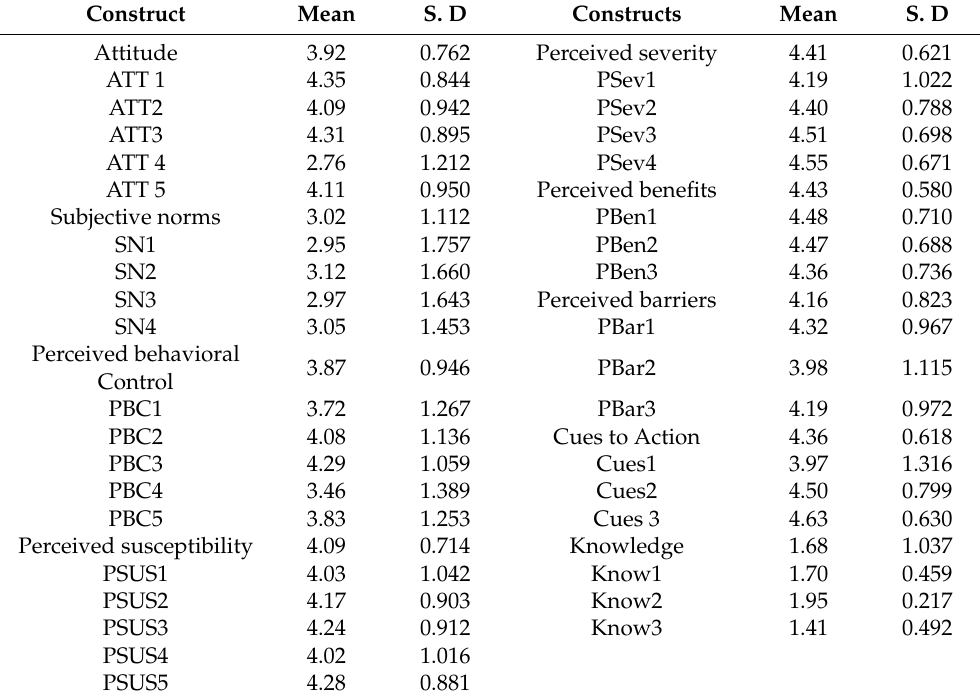
Table 3. Descriptive statistics of constructs and items .